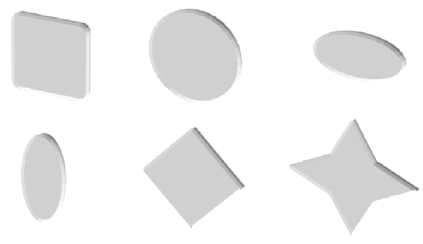
Figure 2: Typical basic shapes of the surface